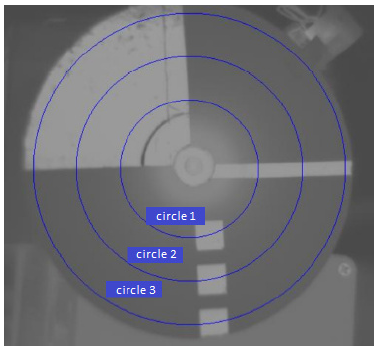
Figure 11. Graphical time counter on the red monochromatic